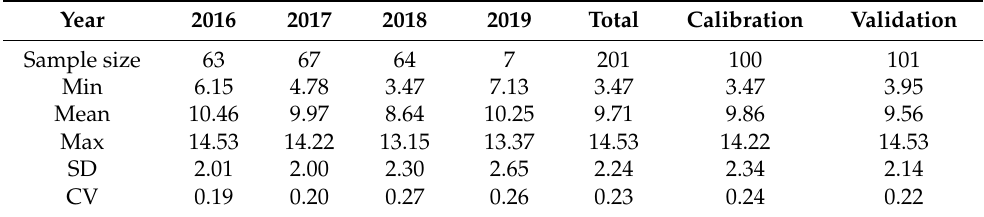
Table 3. Summary statistics of maize grain yield (t/ha) during 2016–2019 in Jilin province. Note: Min, minimal yield; Mean, mean yield; Max, maximal yield; SD, standard deviation; CV, coefficient of